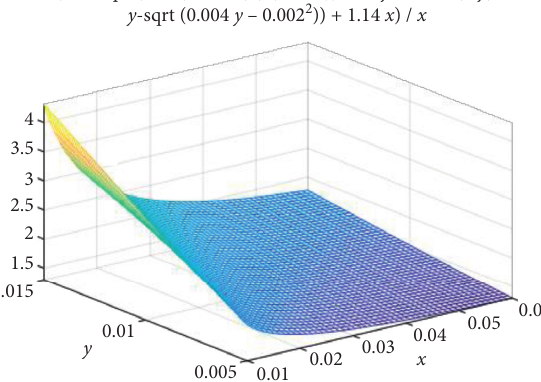
Figure 27: Change of heated area of the threaded